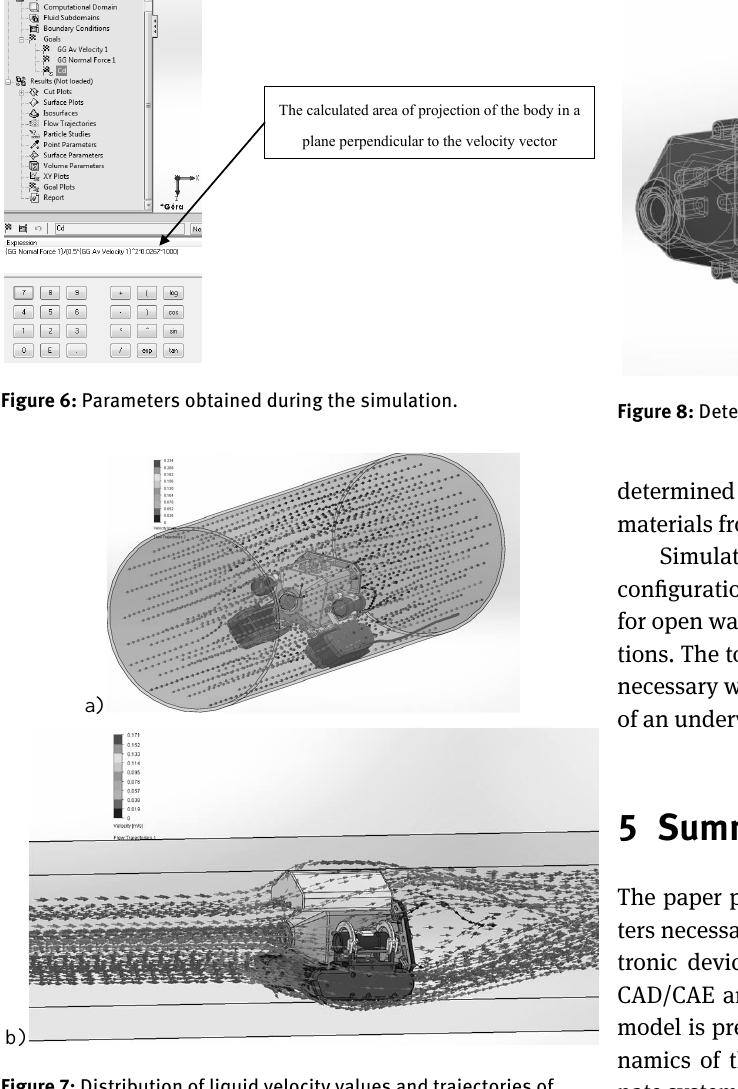
Fig. 8. Determining parameters for the robot body